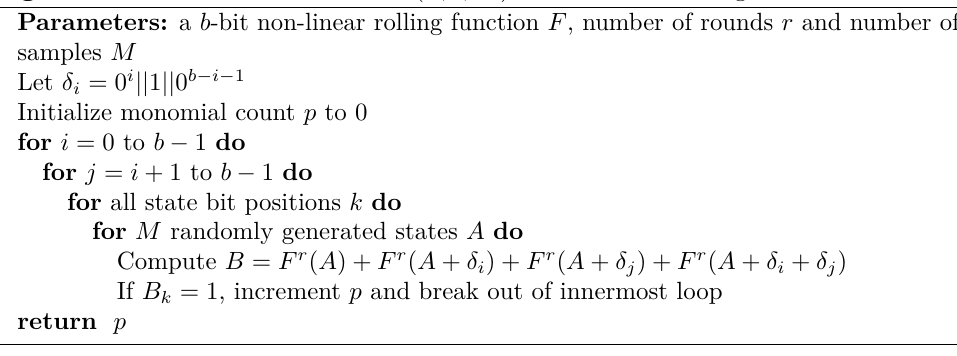
Algorithm 3 Definition of monomials( F, r, M ) for monomials of degree two. Parameters: a b -bit non-linear rolling function F , number of rounds r and number